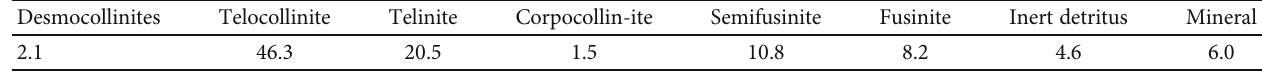
Table 1: Quantitative statistical results of coal samples ’ macerals.